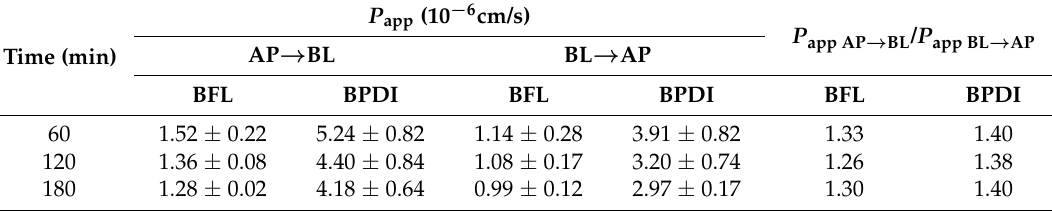
Table 3. P app values of bi-directional transport of BFL and BPDI with time course.